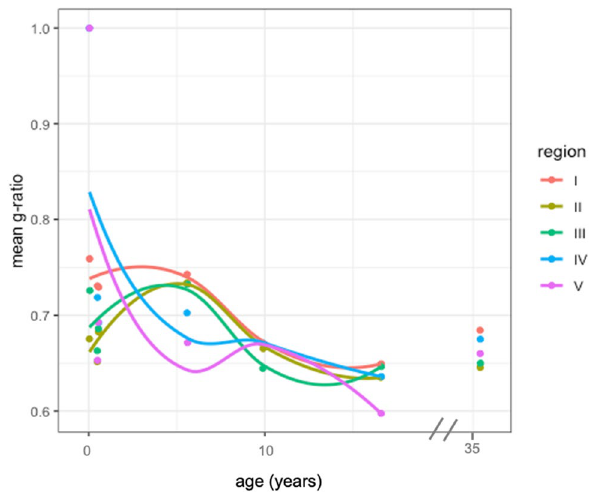
Figure 5. Scatterplot of mean g-ratio by age seperated by region. The lines were fit with LOESS regression. One subject (35.4 years) was excluded from LOESS regression.